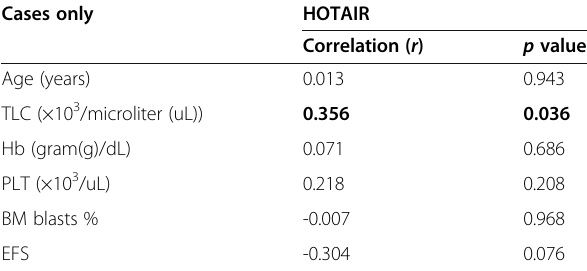
Table 6 Correlation of HOTAIR with age, laboratory data, and EFS (months) of the studied patients Cases only